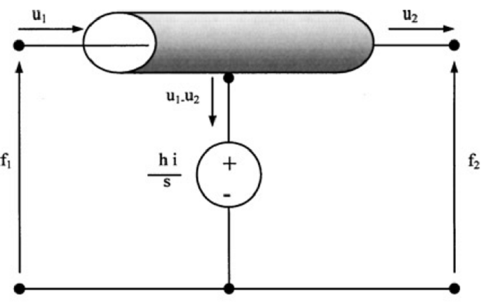
Figure 10. Analogous circuit based on a transmission line for the thickness ‐ mode transducer.